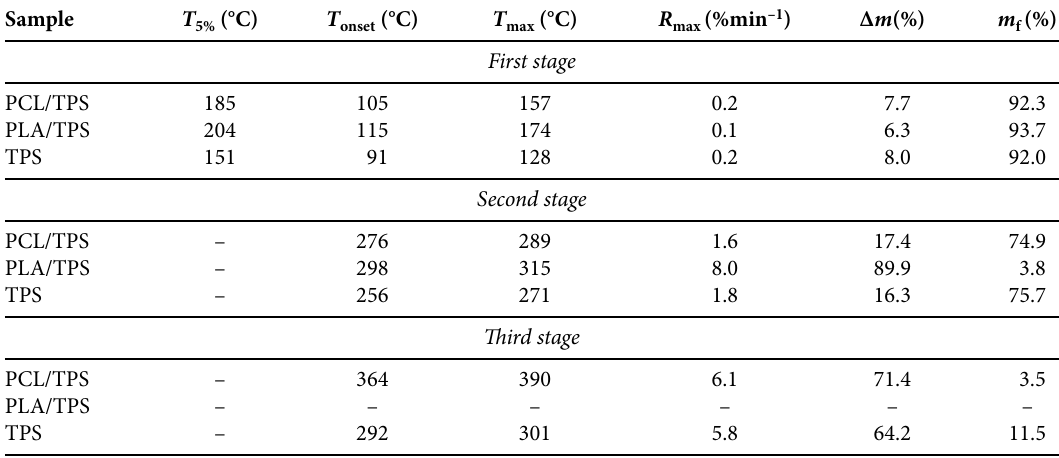
Table 2. The characteristics of thermal degradation curves of PCL/TPS and PLA/TPS blends (heating rate 2.5 °C min –1 ) Sample